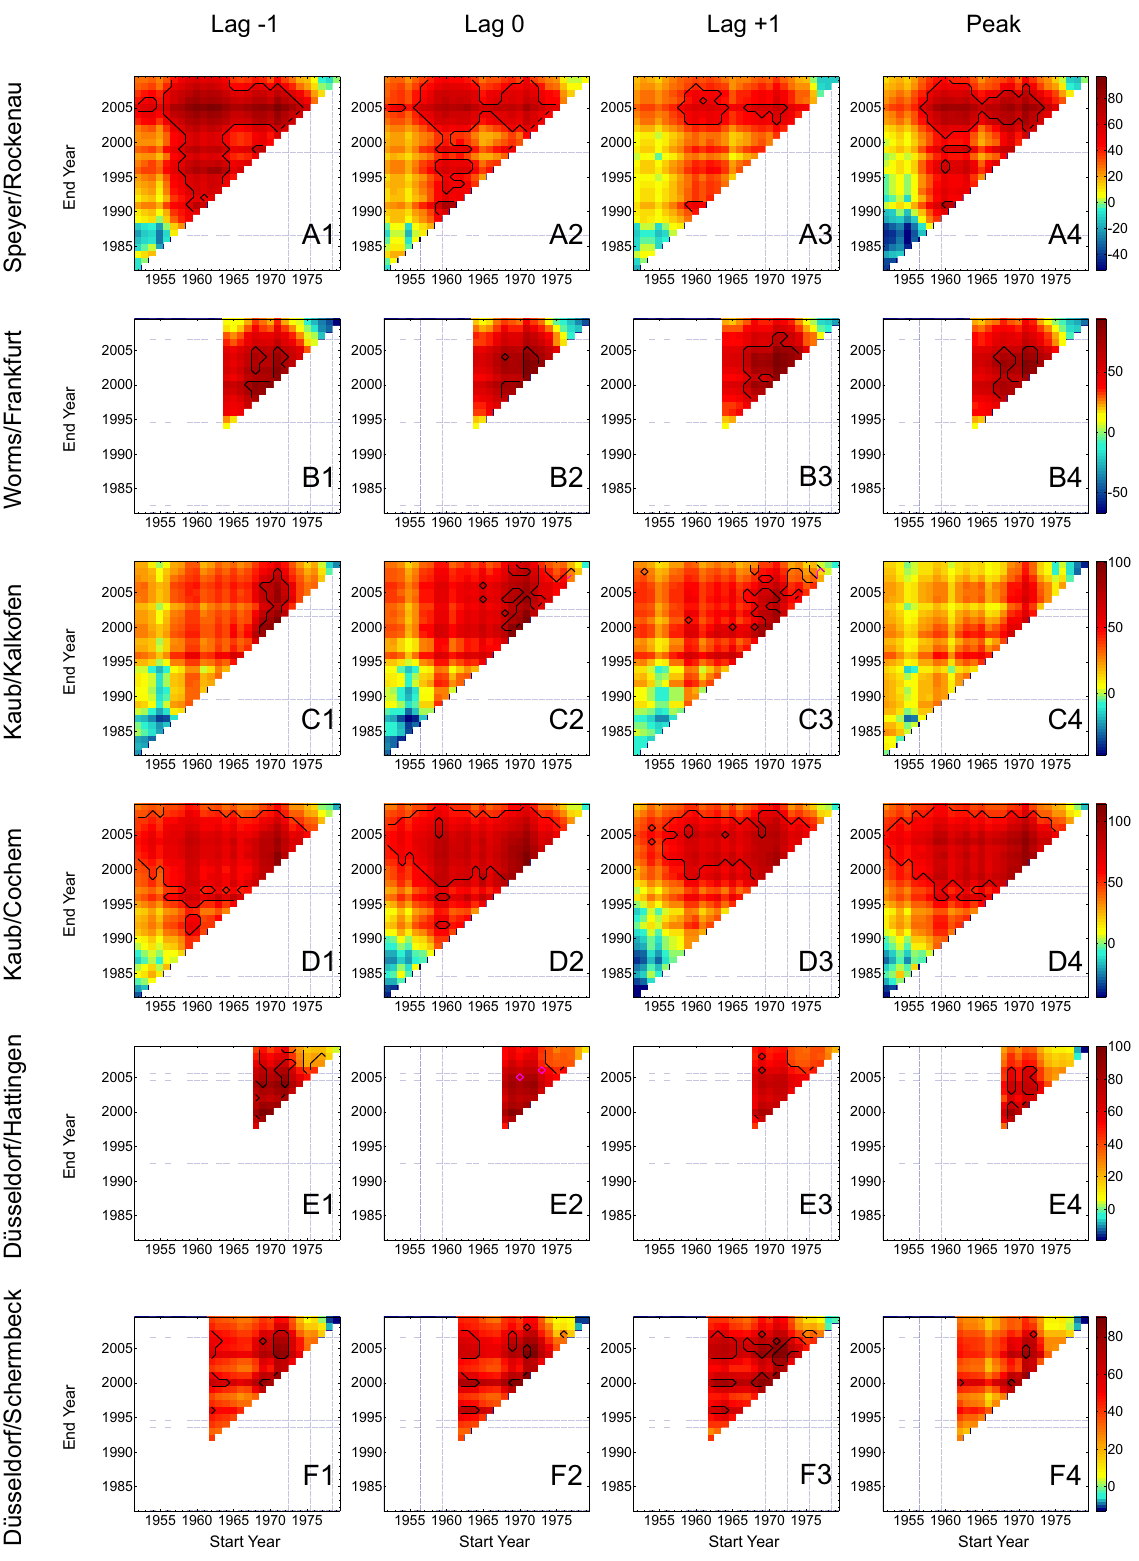
Fig. 6. Multiple flood trends in discharge series corresponding to the Rhine annual peak flows with − 1/0/ + 1 day lag and in maximum discharge series of the corresponding tributary flood event. Black contours encompass the regions of statistically significant trends. Pink contours show the periods of significant monotonic trends for which the linear model (KTRL) is not